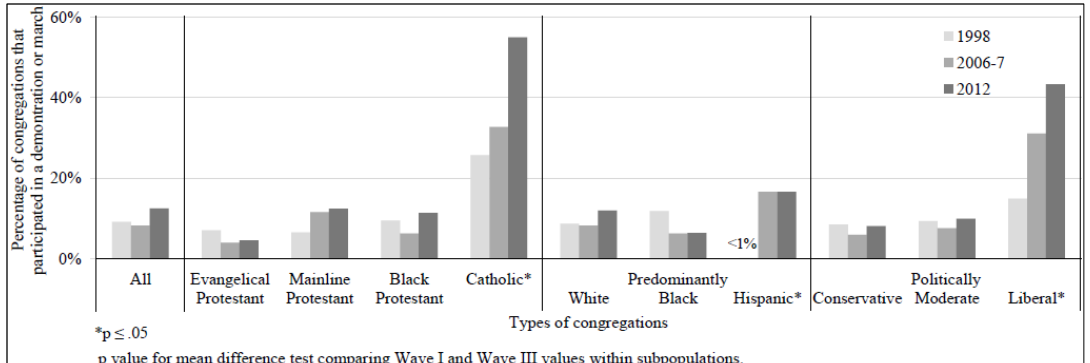
Figure 7. The percentage of congregations by subpopulation that participated in a demonstration or march by wave.